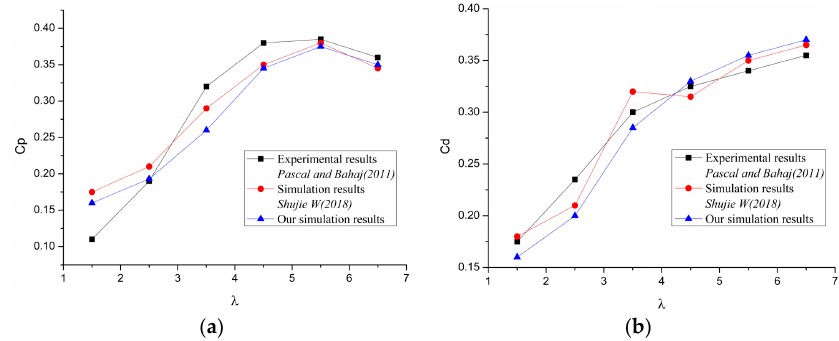
Figure 6. ( a ) Comparison of the Cp vs. λ response of the experimental results of [26,27] and the simulation results of [25]; ( b ) comparison of the Cd vs. λ response of the experimental results of [26,27] and the simulation results of [25].